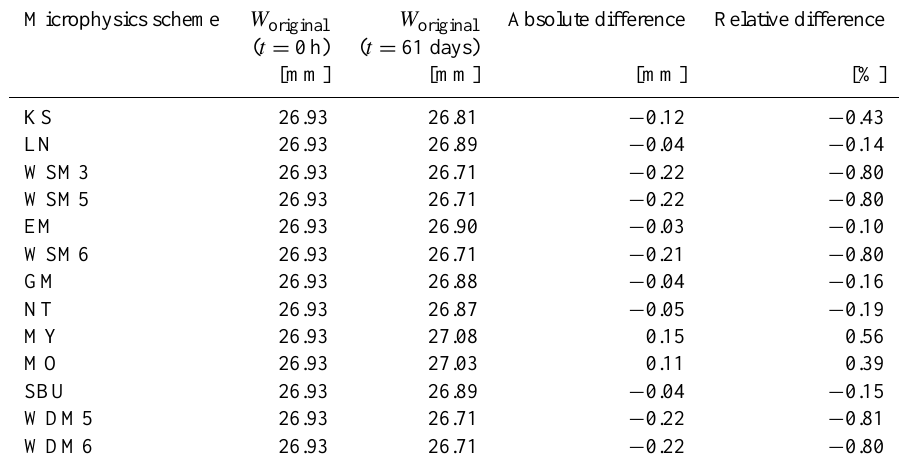
Table 3. The original total water mean column density W original (see Eq. 7) at t = 0h and at t = 61 days. When the microphysical schemes convert water from one phase into another or one type of particle into another, small water mass gains or losses may occur. The original amount of total water may slightly vary in time, as shown in this table.